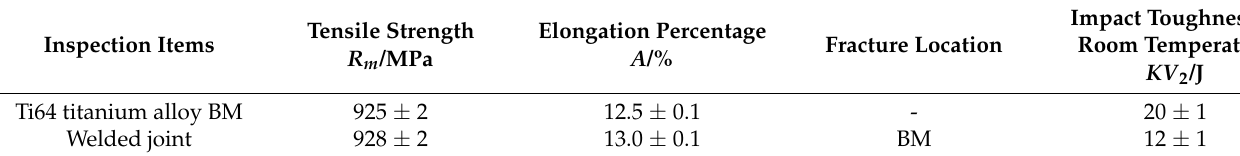
Table 3. Tensile and impact properties of titanium alloy BM and welded joint.